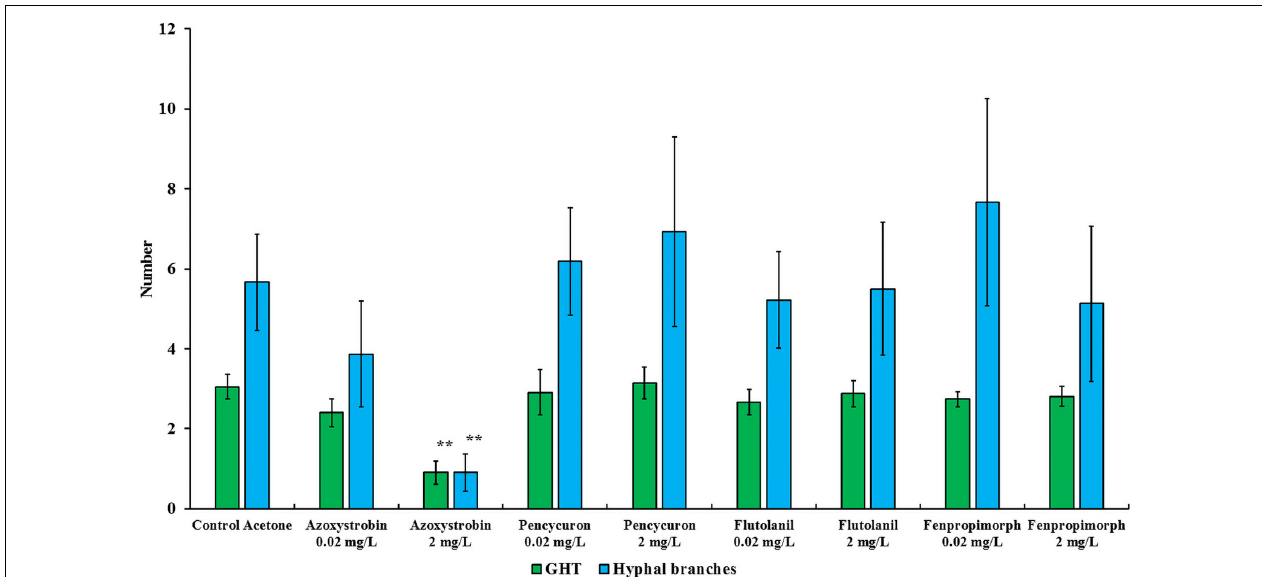
FIGURE 2 | Number of growing hyphal tips (GHTs) and their hyphal branches produced in the hyphal healing mechanism (HHM) of Gigaspora sp. MUCL 52331 in absence (control acetone) or in presence of increasing concentrations of azoxystrobin, pencycuron, flutolanil and fenpropimorph (0.02 and 2 mg L − 1 ). Data were obtained 48 h after hyphal physical injury and addition of MSR medium containing or not the fungicide at the place of hyphal injury. Kruskal-Wallis followed by a Dunn multiple comparison post hoc test was performed to validate significant difference between fungicides treatments and their respective control acetone: *, **, and *** indicate P < 0.05; 0.01 and 0.001, respectively. P -values below 0.05 are significant.